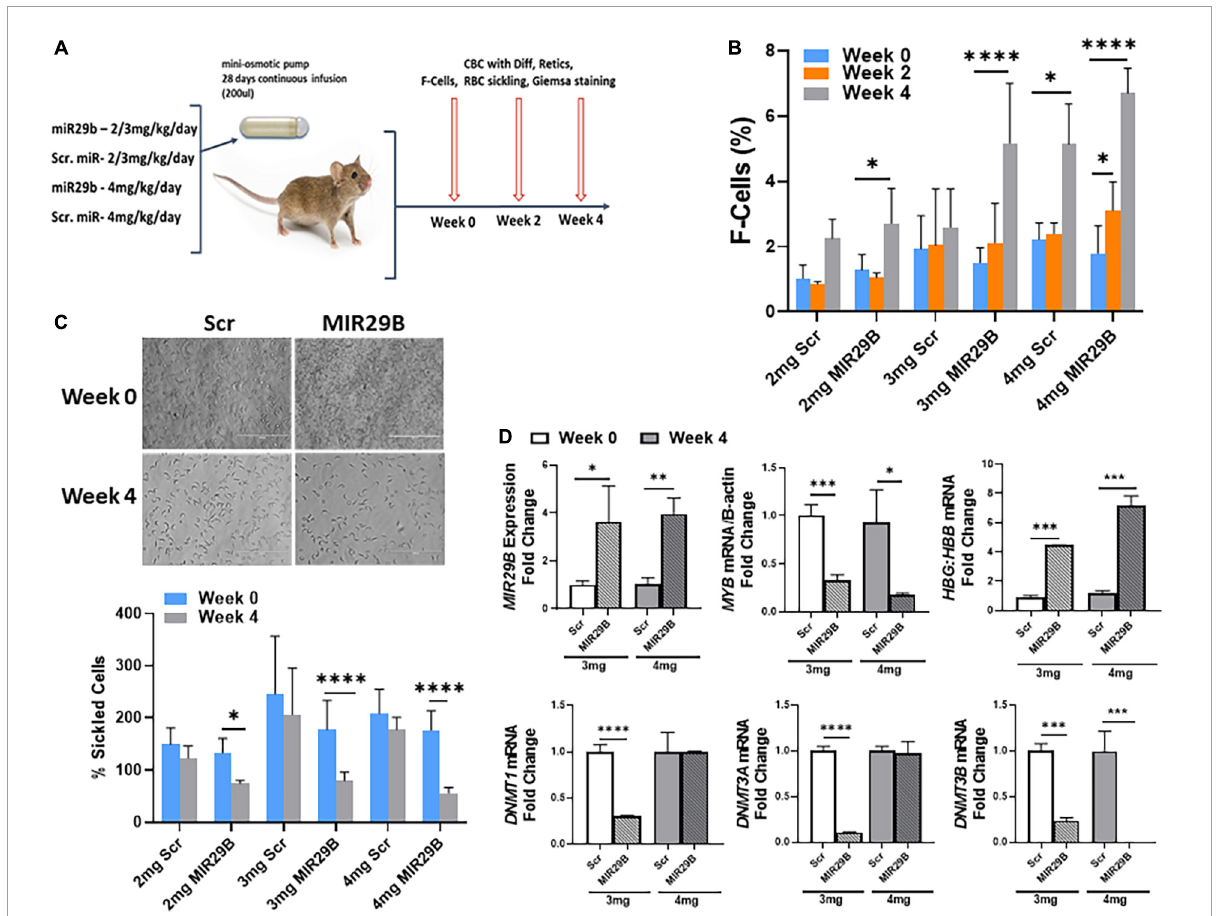
FIGURE4 MicroRNA29B (MIR29B) induces HbF in humanized Townes sickle cell mice. (A) Townes SCD mice, which express human α -globin, γ -globin, and β S-globin genes and exhibit phenotypes including chronic hemolysis and sickling similar to human SCD, were surgically implanted with a mini-osmotic pump (Alzet) that continuously released MIR29B mimic at the concentration shown over 28 days. Age-and sex-matched mice ( n = 4–10 per group) were treated and blood was collected at weeks 0, 2, and 4 for complete blood counts (CBC) with differential, reticulocytes, %F-cells, and red blood cell sickling under hypoxia conditions. Treatments consisted of 4 mice per group (2 males and 2 females) for MIR29B or SCR mimic at 2, 3, and 4 mg/kg/day and water vehicle and HU (100 mg/kg/day) controls. Tail–vein blood samples were collected in EDTA blood tubes at week 0, 2, and 4 along with weights. Evaluation of the effects of MIR29B on bone marrow hematopoiesis, were conducted by (B) Shown are bar graphs of the percentage of HbF-positive cells (F–cells) in erythroid progenitors isolated from Townes SCD mice and stained with fluorescein isothiocyanate-labeled anti-HbF antibody under the different treatment conditions. (C) Shown are bar graphs of the percentage of sickled cells obtained from freshly collected EDTA blood from sickle mice incubated under 1% hypoxia conditions for 12 h following the treatment conditions. (D) RT-qPCR analysis of MIR29B, MYB , DNMT gene expression and the HBG -to- HBB mRNA ratio as a function of HBG / HBG + HBB in mice treated with MIR29B or Scr control; * P < 0.05, ** P < 0.005, *** P < 0.0005, and **** P < 0.0001 is statistically